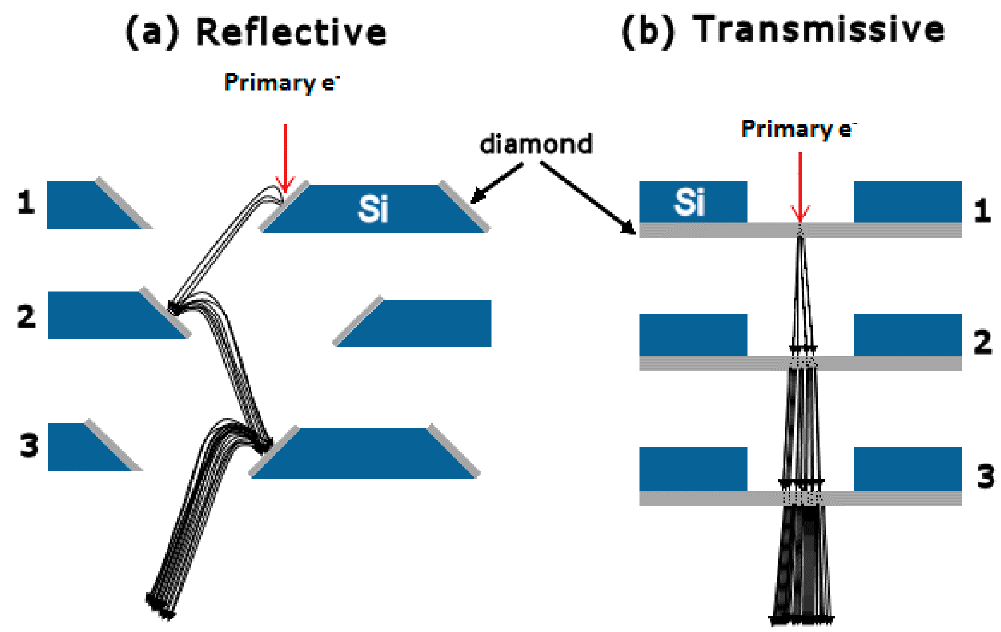
Figure 2. Two geometries ( a ) reflection and ( b ) transmission typically used for secondary electron multiplication dynode devices. Here, thin diamond film is used as the dynode material. Three multiplication stages are shown for each, with each stage having a higher positive bias compared to the previous stage. The figure is reproduced from reference [6].